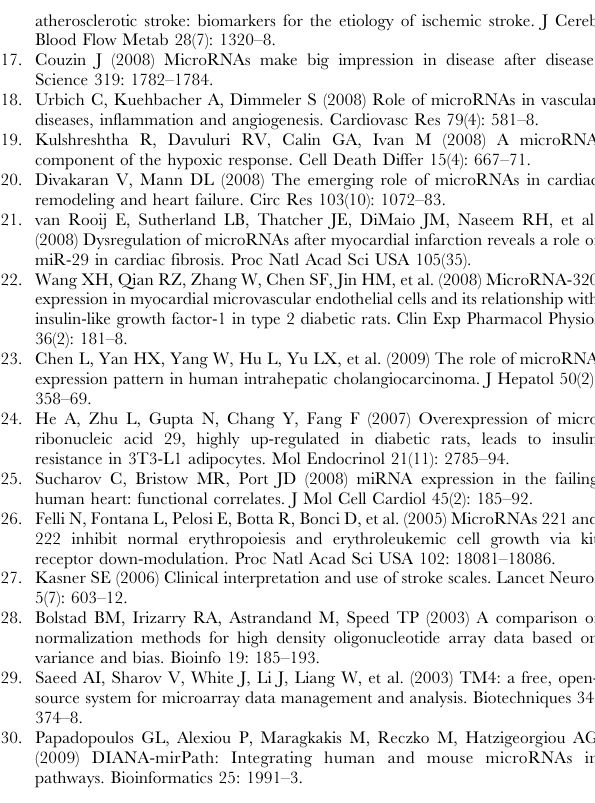
Table S5 Patient profile and medications (a) Demographic comparison and (b) Detailed medication and modified Rankin Score of young Asian stroke patients selected for the study. Controls (n= 5) included 3 males and 2